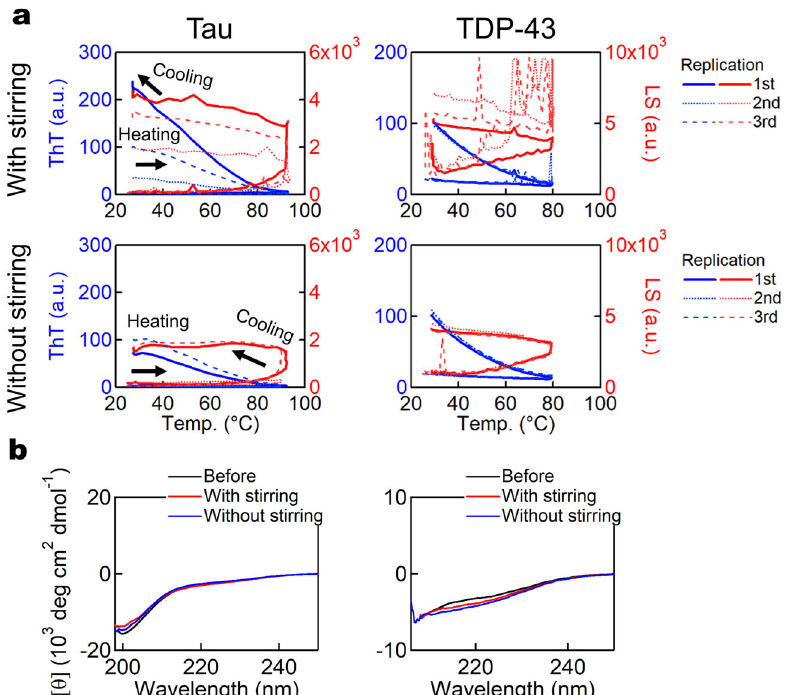
Fig. 4 Boiled egg-like aggregation of type B proteins. a ThT assays of tau and TDP-43 upon heating in the presence (upper) or absence (lower) of stirring. n = 3. b CD spectra of each sample before and after the ThT assays.